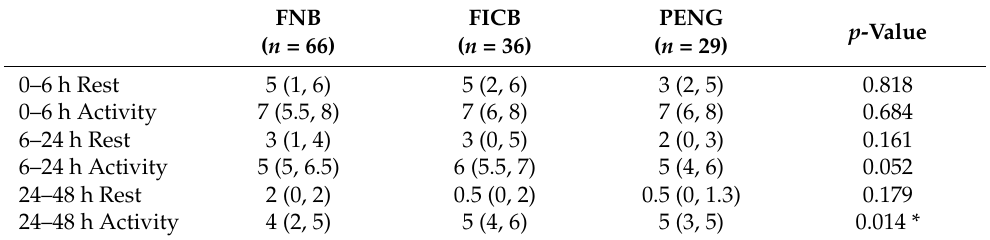
Table 4. SubgroupanalysisofVASbetweenthePNBgroupsforpatientswhounderwenttotalhiparthroplasty. FNB ( n = 66)